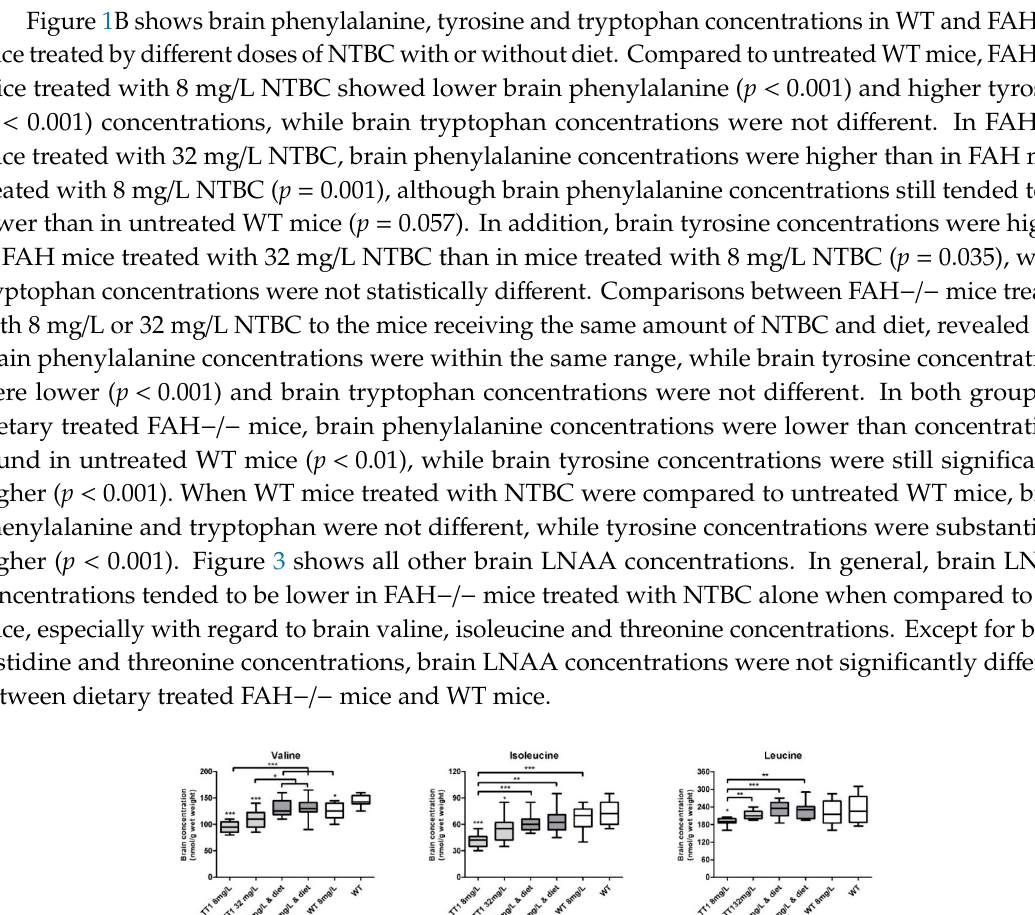
Figure 4. Concentrations of brain neurotransmitters and its metabolites. Numbers of mice are n = 13 or n = 14 for all treatment groups. Untransformed data are expressed as boxplots (min–max whiskers). * p < 0.05, ** p < 0.01 and *** p < 0.001 (two-sided).